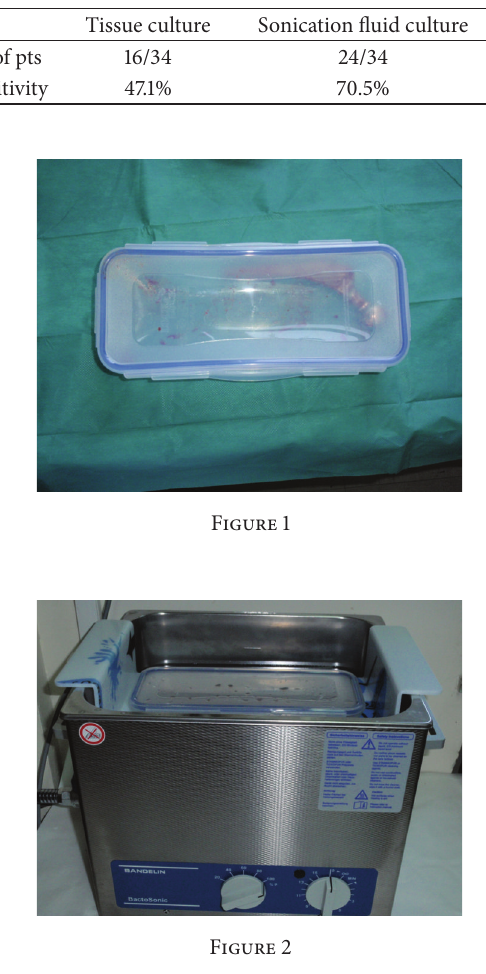
Table 1: Sensitivity and ESR-CRP values prior to and six weeks after prosthesis